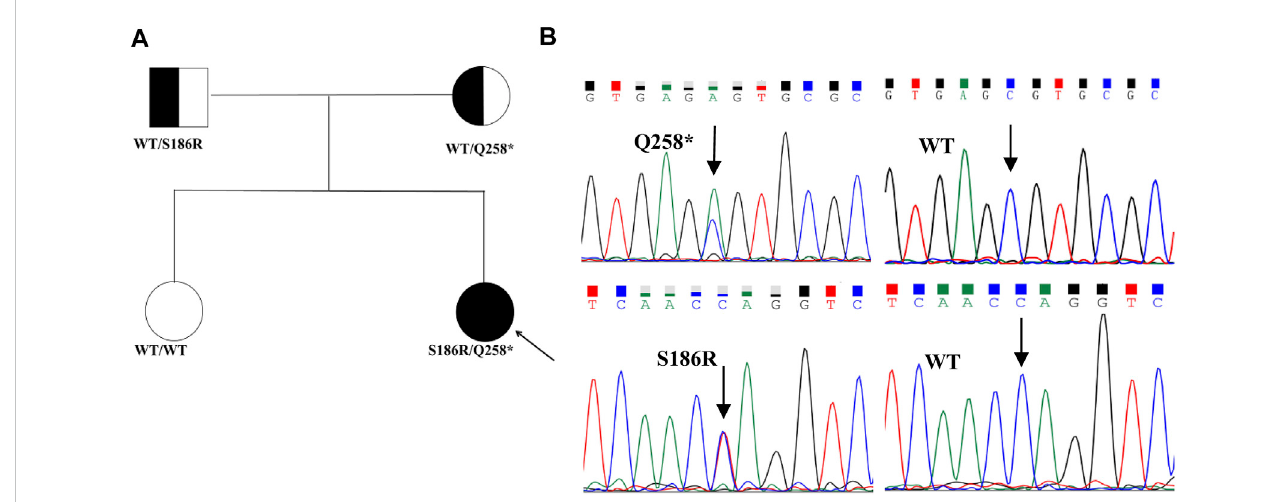
FIGURE 1 Pedigrees and sequencing chromatograms of the mutations identi fi ed in the families. (A) Family pedigrees, squares, and circles indicate males and females, respectively. Shaded symbols indicate the proband (indicated by the arrow). The half-shaded symbols indicate carriers (B) . The heterozygous STAR c558C > A (p.S186R) and c.772C > T (p.Q258*) mutations were identi fi ed in the proband. The arrow indicates the mutation